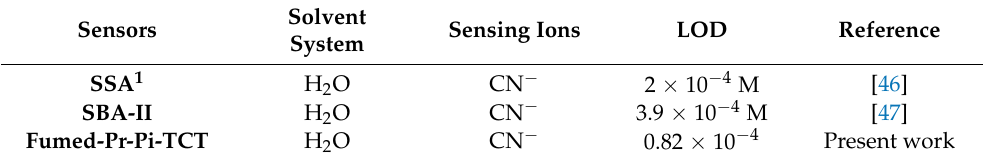
Table 1. Comparison between various